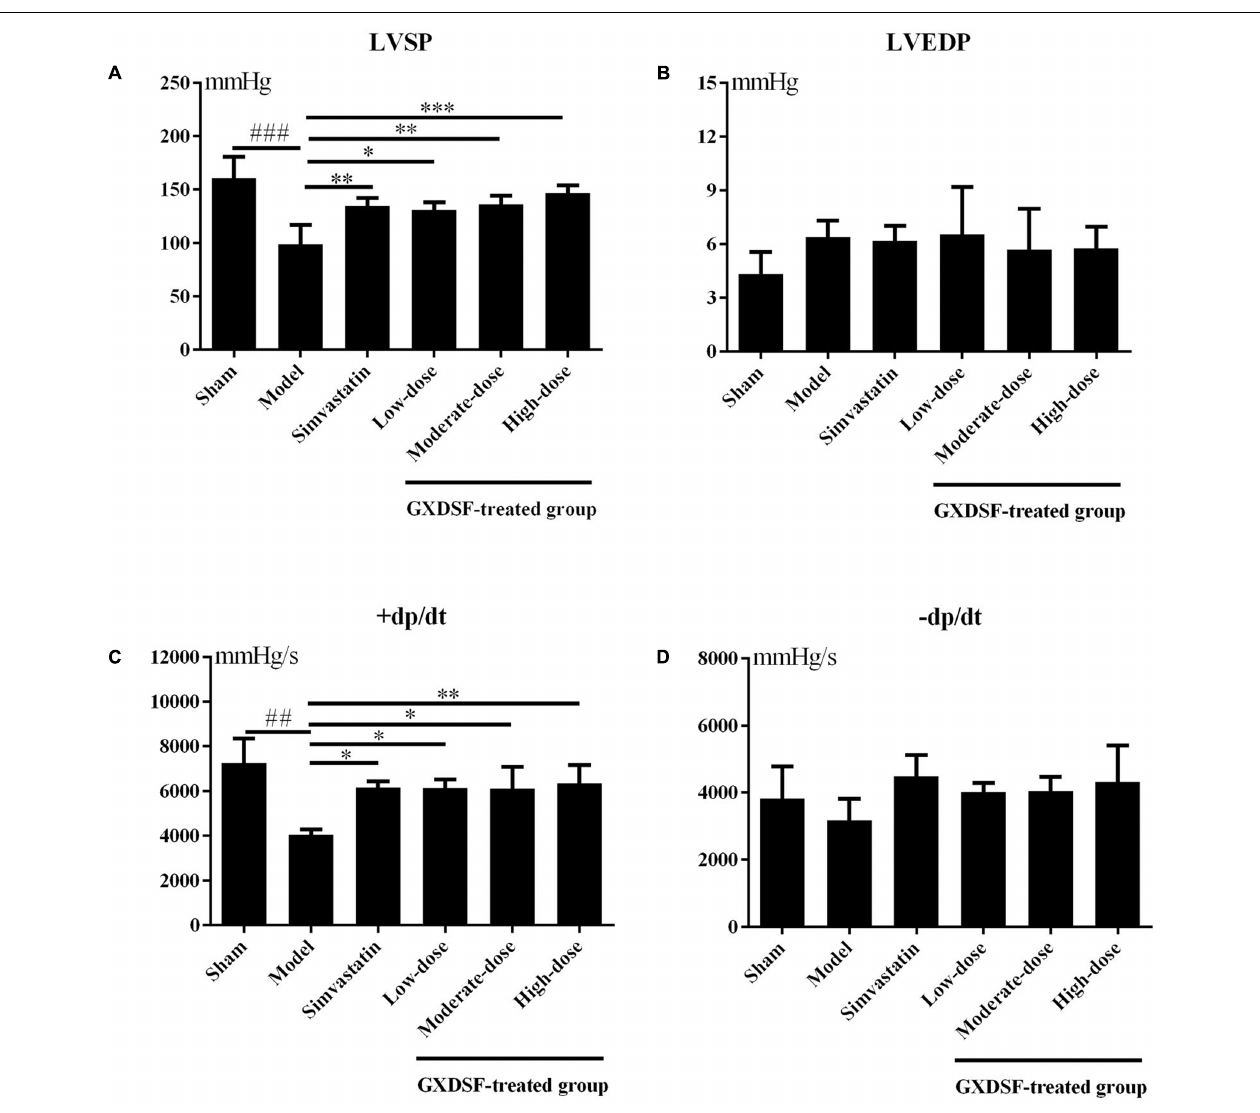
FIGURE 1 | Haemodynamic parameters, including LVSP (A) , LVEDP (B) , +dp/dt (C) , and –dp/dt (D) , in MIRI-LVR rats treated with different doses of GXDSF. Compared with the sham group: ## P < 0.01, ### P < 0.001. Compared with the MIRI-LVR model group: ∗ P < 0.05, ∗∗ P < 0.01, ∗∗∗ P < 0.001. The data are presented as the mean ± SD ( n = 10 in each